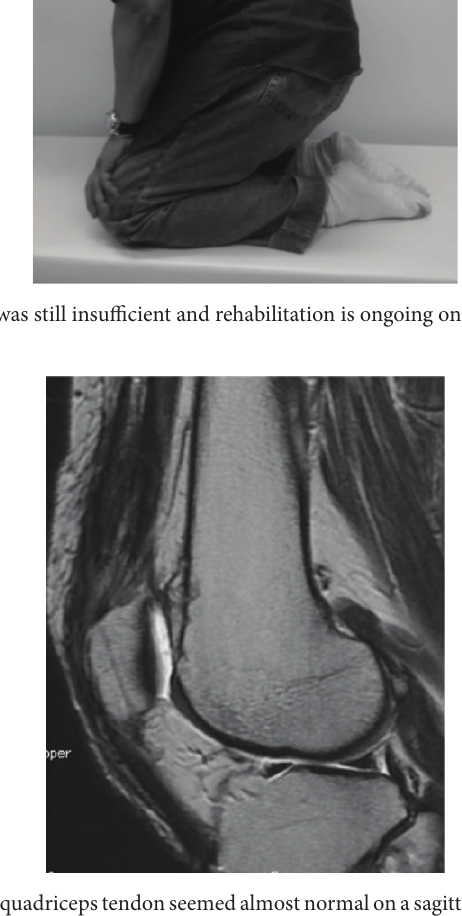
Figure14:ThearchitectureoftherepairedquadricepstendonseemedalmostnormalonasagittalpostoperativeMRIprotondensity-weighted